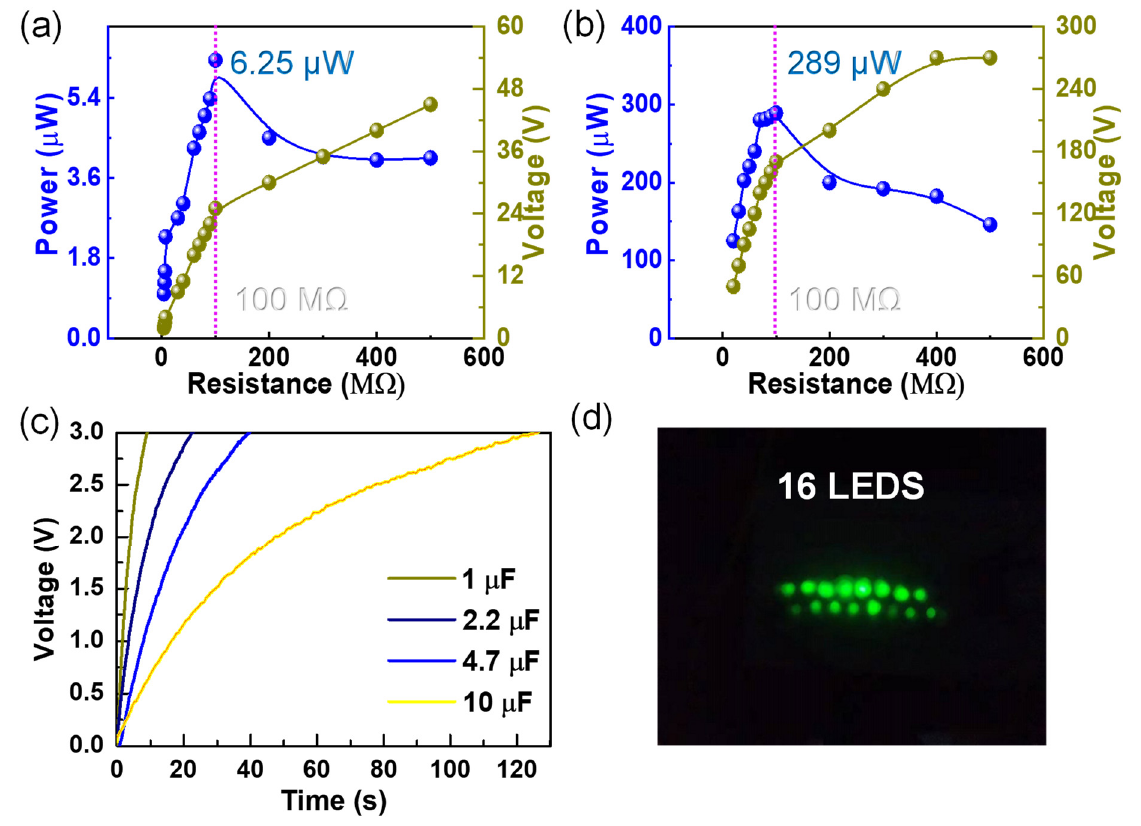
Figure 5. The power and charging characteristics of C − ENG: ( a ) the output power of the W − TENG; ( b ) the output power of the C − ENG; ( c ) the charge curves of the C − ENG for different capacitors; and ( d ) the experiments on lighting LED lights by the C − ENG.